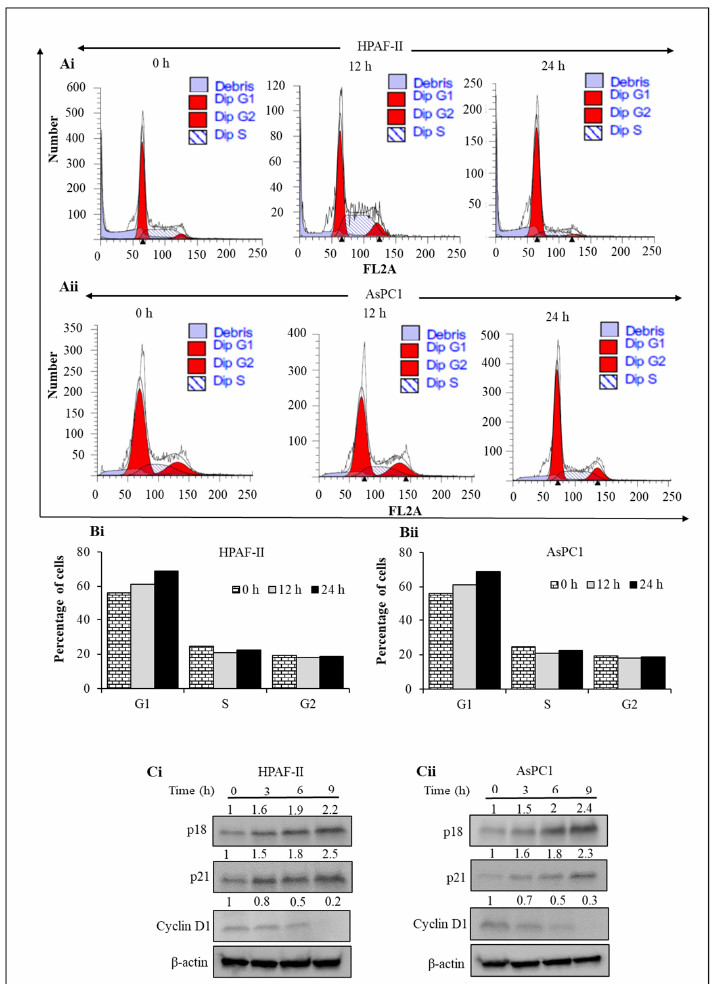
Figure 3. Steviol arrests G1 phase of cell-cycle distribution in pancreatic cancer cells. ( A , B ) Pancreatic cancer cells were seeded and treated with steviol at different time intervals (0, 12, and 24 h). Cell cycle experiment was performed to deter- mine the effect of steviol (10 mM) on G1 cell cycle arrest in HPAF-II ( Ai , Bi ) and AsPC1 cells ( Aii , Bii ); ( C ) steviol modulates the key proteins involved in G1 phase of cell cycle arrest. Pancreatic cancer cells were treated with steviol (10 mM) at different time points (0, 3, 6, and 9 h). Whole-cell lysates were prepared and subjected to Western blotting. The expression level of important cell cycle proteins ( p 18, p 21, and Cyclin D1) were evaluated in HPAF-II ( Ci ) and AsPC1 cells ( Cii ); the numbers over the blots represent the relative quantification of band intensities with the internal control ( β -actin).